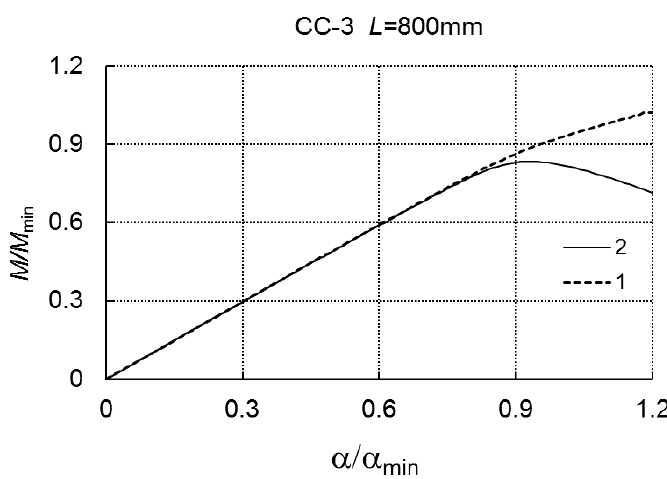
Figure 14. M / M min versus α / α min for LC-3 and L = 800 Figure 14 . M/M m in versus α / α min for LC-3 and L = 800 mm.